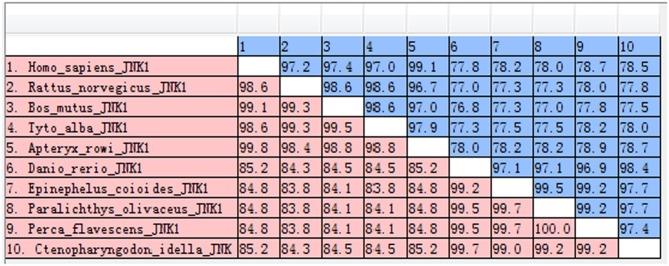
The similarities (red) and identities (blue) of JNK sequences were analyzed by the MatGAT v2.02 software.